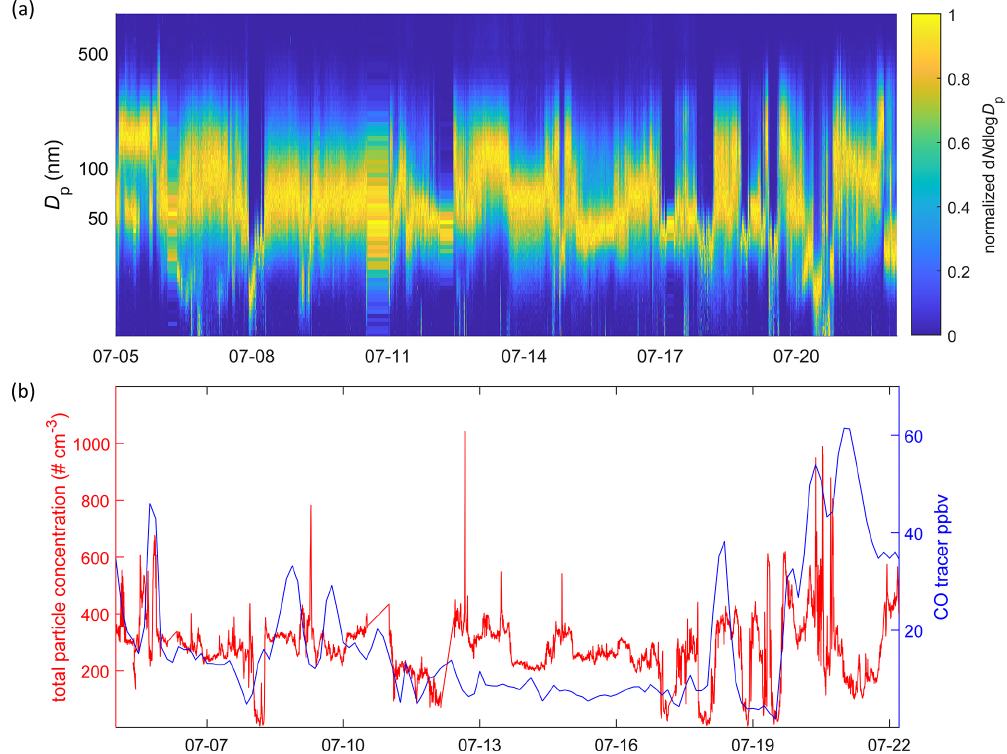
Figure 2. (a) Normalized particle size distribution from 10 to 800nm from SMPS measurements, and (b) the SMPS-derived total particle concentration (left y axis, red line) and CO tracer concentration retrieved from FLEXPART simulations (right y axis, blue line) from 5 to 21 July